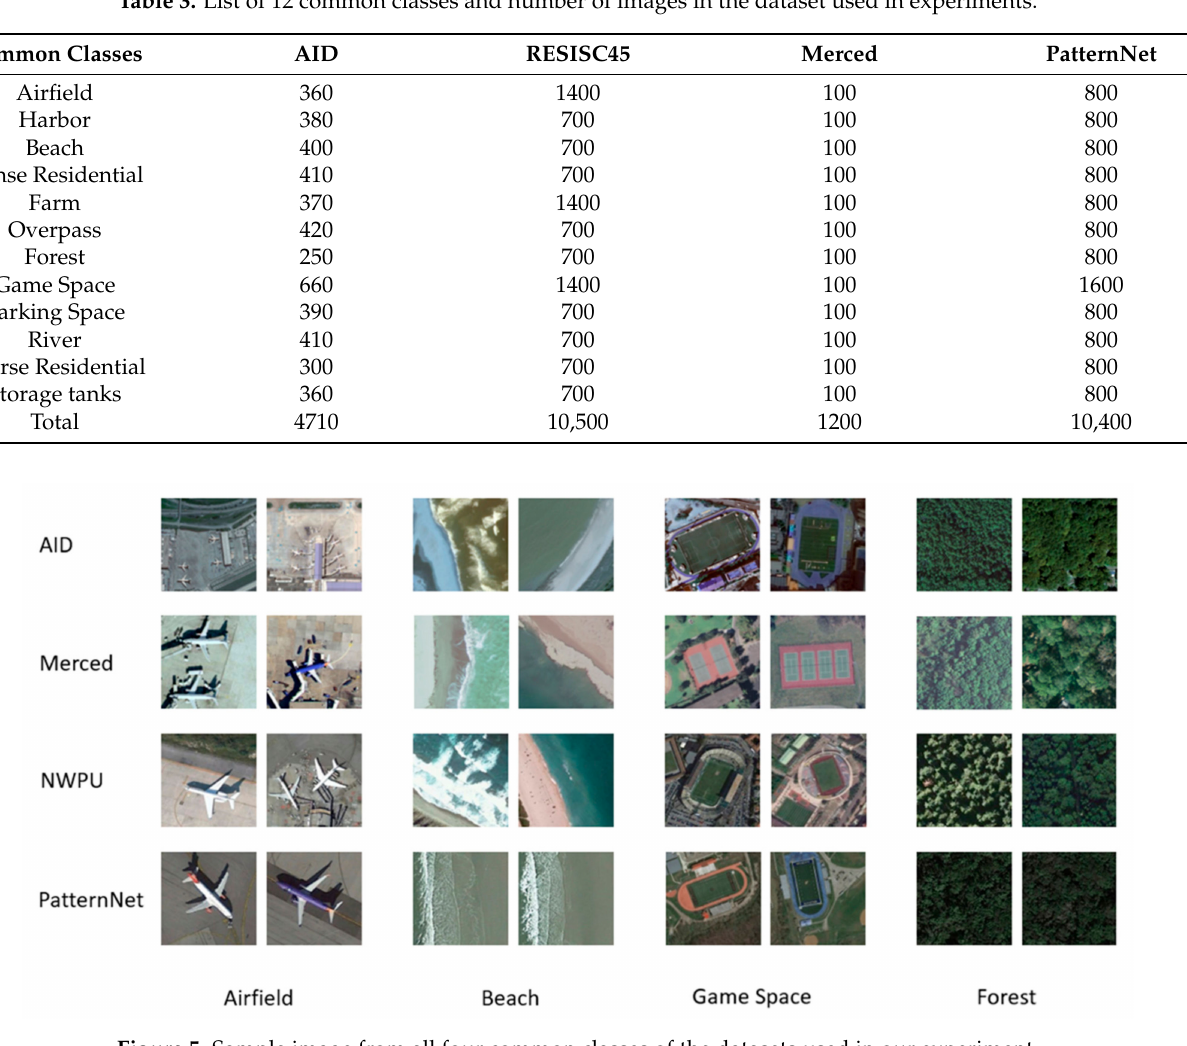
Figure 5. Sample image from all four common classes of the datasets used in our